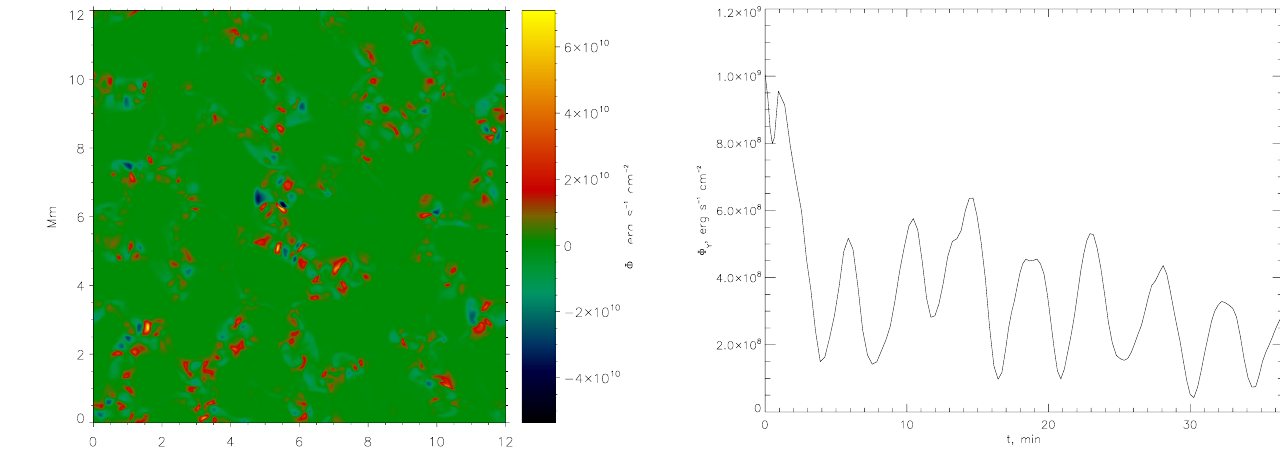
Fig. 3. Distribution of the vertical component of Poynting flux vec- tor taken at the same height as Fig. 1.